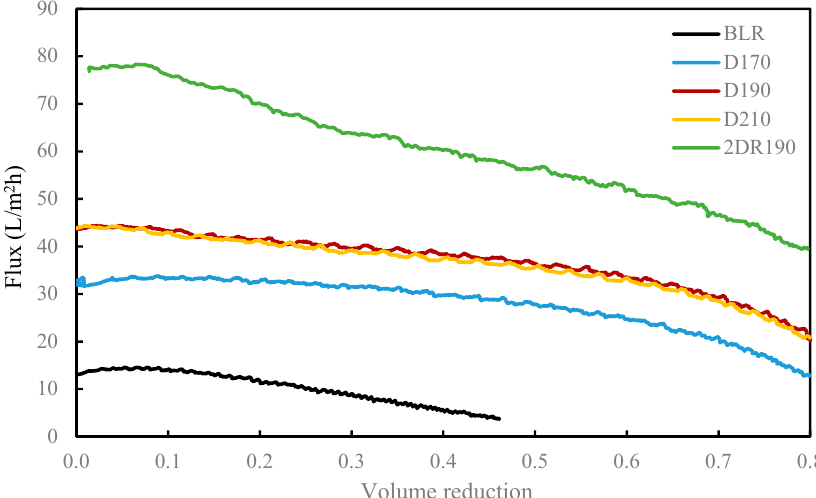
Figure 6. Flux during the diafiltration of 170–210 °C depolymerized BLR by GR95PP membrane. The temperature was 50 °C, the transmembrane pressure was 5.5 bar and the cross-flow was 0.5 m/s.